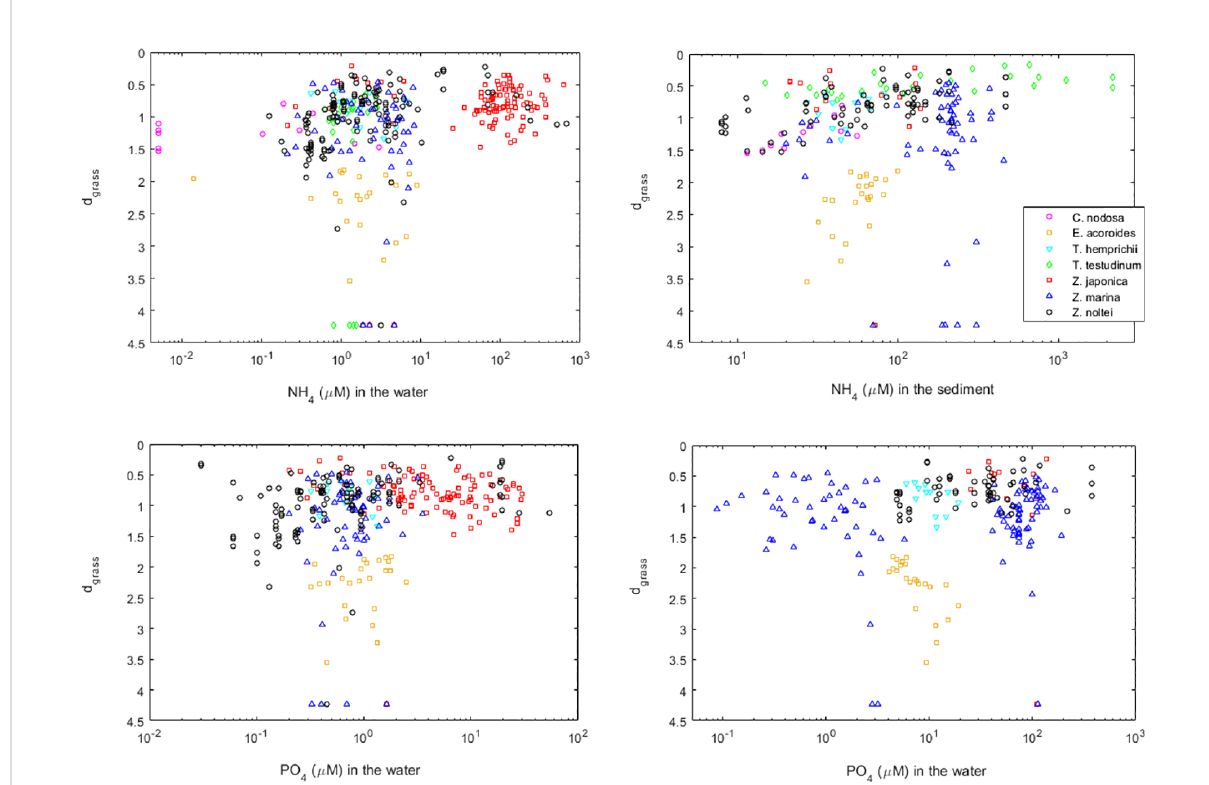
FIGURE 5 Health of seagrasses worldwide and their relation with the concentrations of ammonium and phosphate in the water and in the sediments. Seagrass health is indicated by their distance (d grass ) to the seagrass IBL (i.e., their ef fi ciency of space